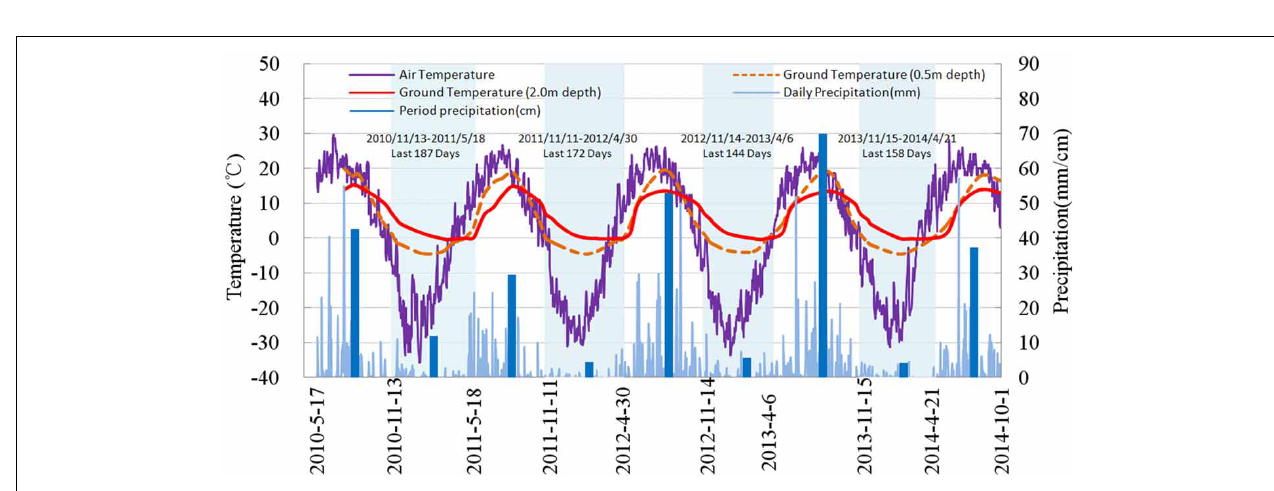
FIGURE 10 | The profiles of Landslide K178 + 530 perpendicular to the slide